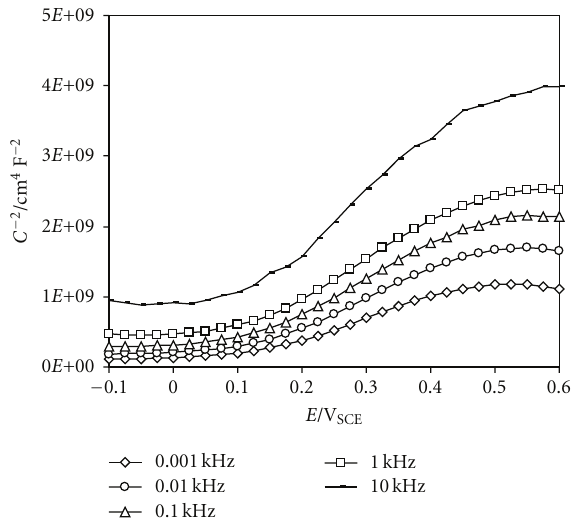
Figure 3: Mott-Schottky plots at di ff erent frequencies of the passive films formed on surface in 0.05M H 2 SO 4 . The electrode is passivated for 1h at 0.6V SCE .